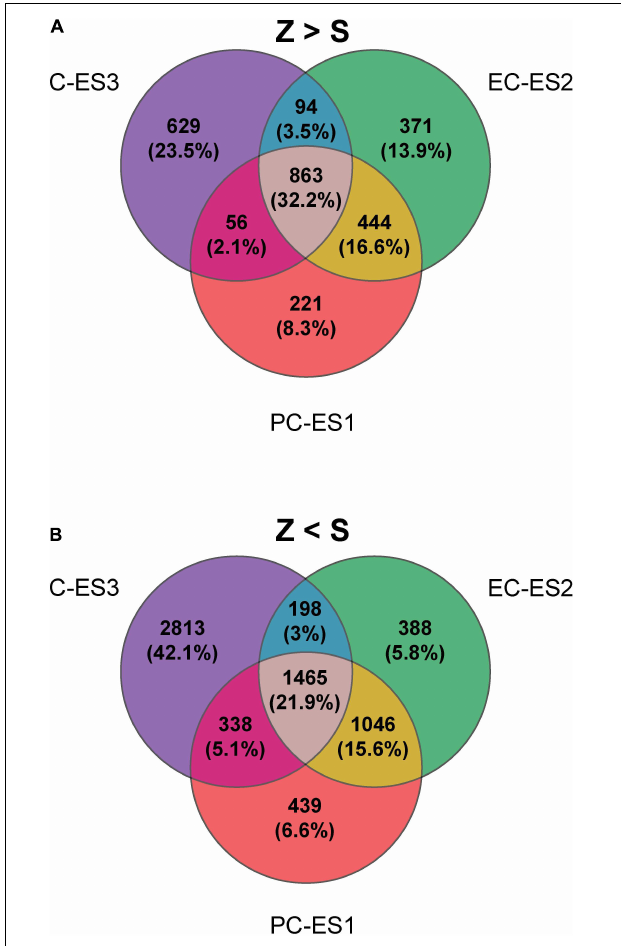
FIGURE 2 | Global differential expression analyses. Venn diagrams of differentially expressed genes in zygotic (Z) versus somatic (S) embryos in three consecutive sets of similar developmental stages during late embryogenesis: PC and ES1, EC and ES2, C and ES3, respectively. The number of genes showing a fold-change > 2 between consecutive stages of development is shown. (A) Genes overrepresented in zygotic (Z) compared the somatic (S) stages are considered. (B) Genes underrepresented in the zygotic are considered.